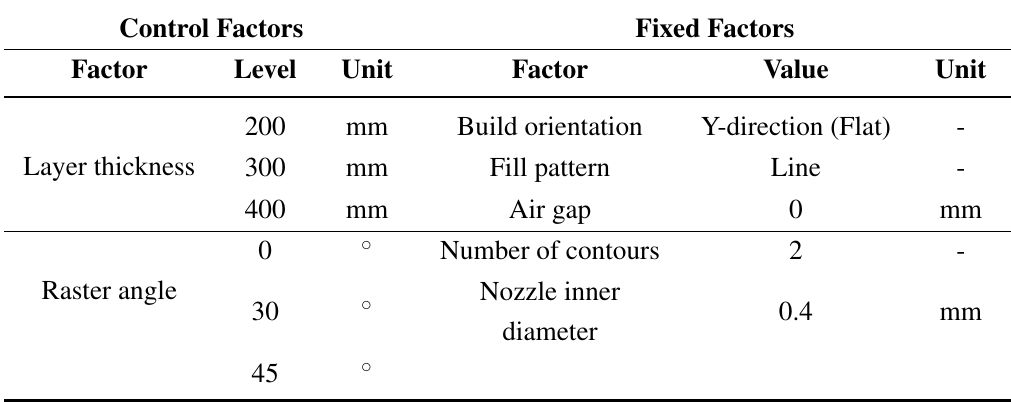
Table 1. The printing parameters of polyether-ether-ketone (PEEK) 3D printing.